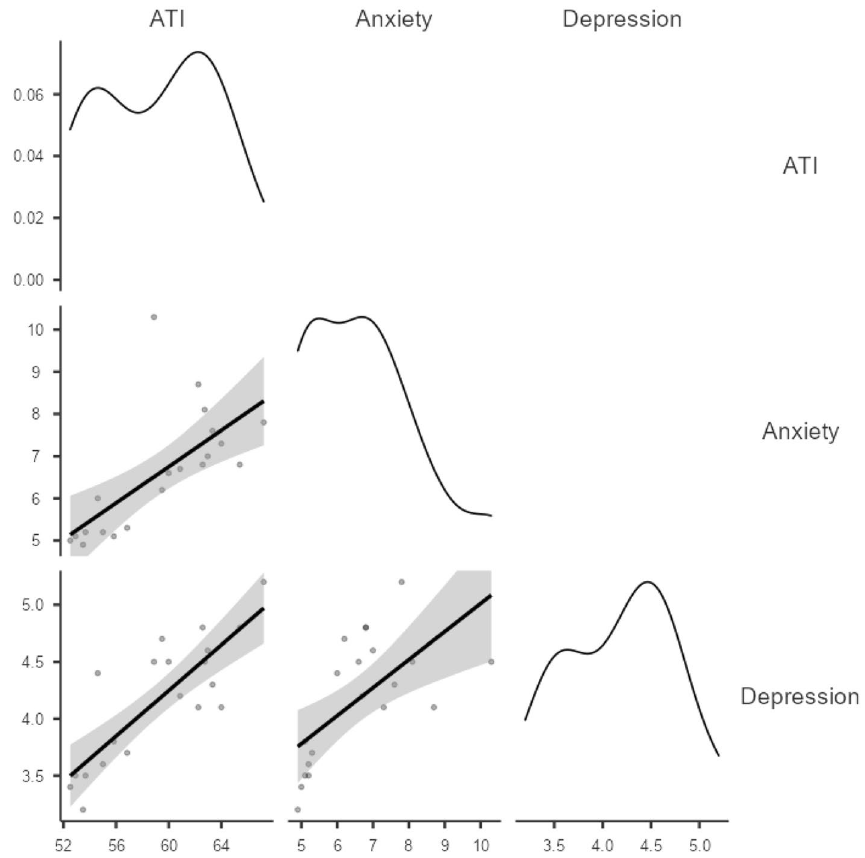
Figure 1. Correlation plots for ATI, survey Anxiety and Depression measures. Grey areas indicate SEs and distribution shapes